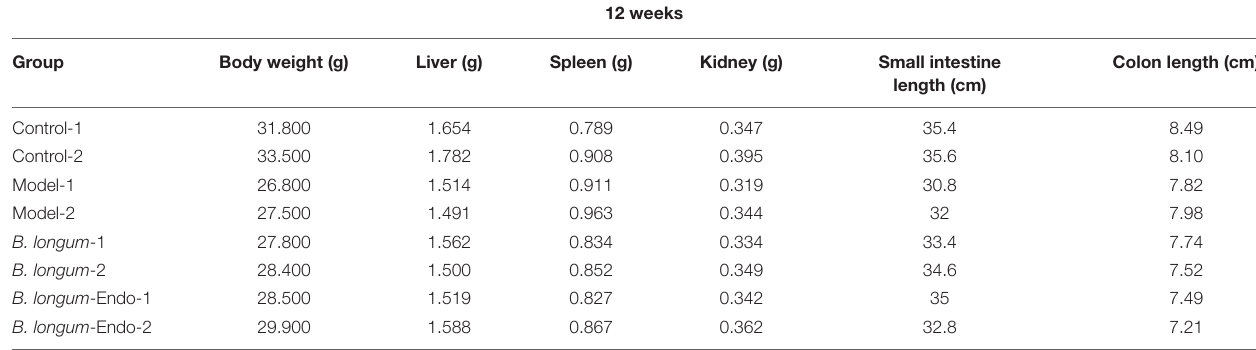
Figure 5 . In level 2 KEGG pathways, intestinal flora